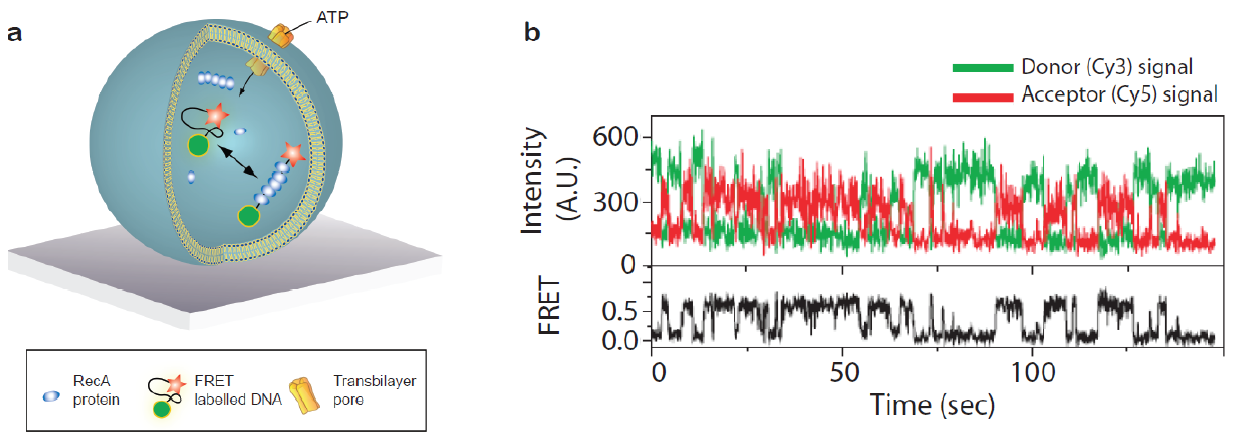
Figure 5. Single molecule recording of protein-DNA interactions driven by ATP inside a single vesicle. (a) A single strand of DNA labelled with a FRET pair encapsulated inside a surface-tethered vesicle together with the ATPase RecA (approximately seven copies per vesicle). In the cell RecA is active in DNA repair upon ATP regulated polymerisation on DNA. Upon RecA assembly the DNA was stretched giving rise to a reduction in FRET. Vesicles were made permeable to small molecules (<1 nm diameter) via pores in the membrane introduced either by utilising a lipid mixture with a phase transition at the temperature of the experiment [49] or using he bacterial toxin alpha-hemolysin [50]. Repeated polymerisation/dissociation reactions were triggered by exchange of ATP through the pores. (b) Fluctuations between stretched (low FRET) and unstretched (high FRET) states of the DNA. Figure b adapted from [49], copyright 2007 National Academy of Sciences,